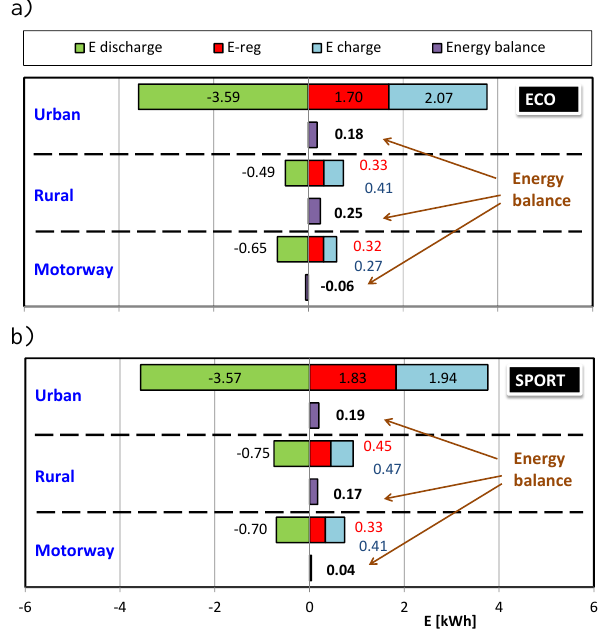
Fig. 11. Energy flow in the hybrid drive system divided into RDE test modes: a) ECO, b) SPORT Analysis of the total energy flow balance indicates their